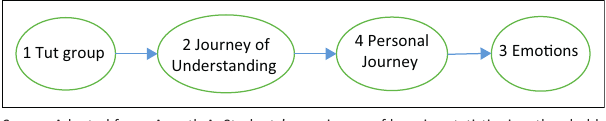
FIGURE 2: Uncluttered systems influence descending order of delta. Arrows are then drawn, as connections between each affinity pair, in the direction of the relationship as represented in the IRD. This version of the each link present in the IRD. 23